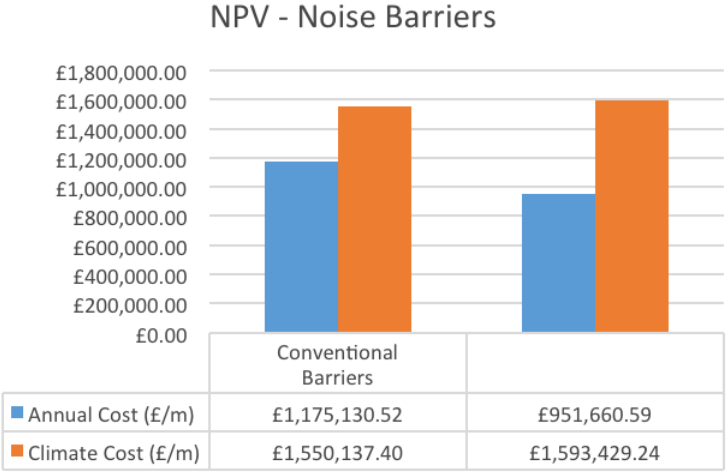
Figure 9. Net present values for two categories of noise barriers.